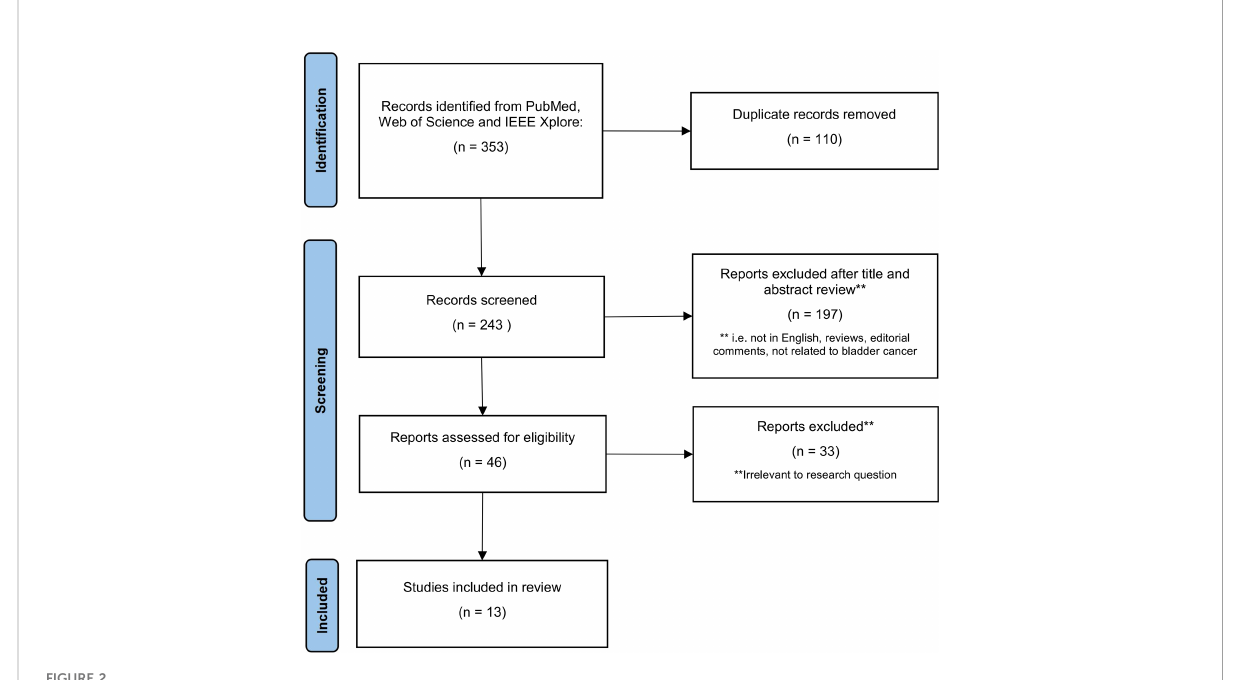
FIGURE 2 Summary of study selection